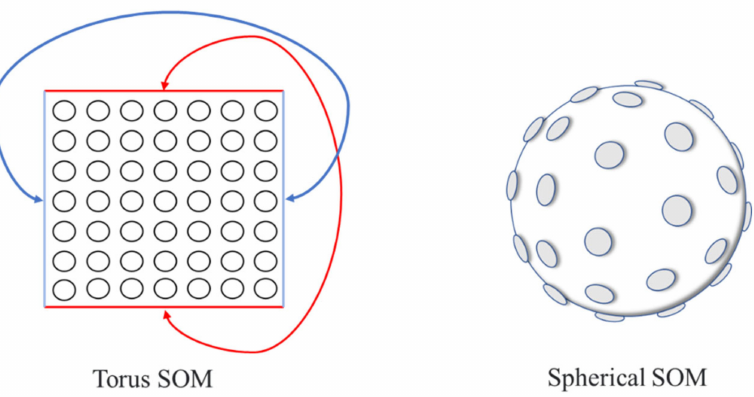
Figure 4. Map shapes the extended